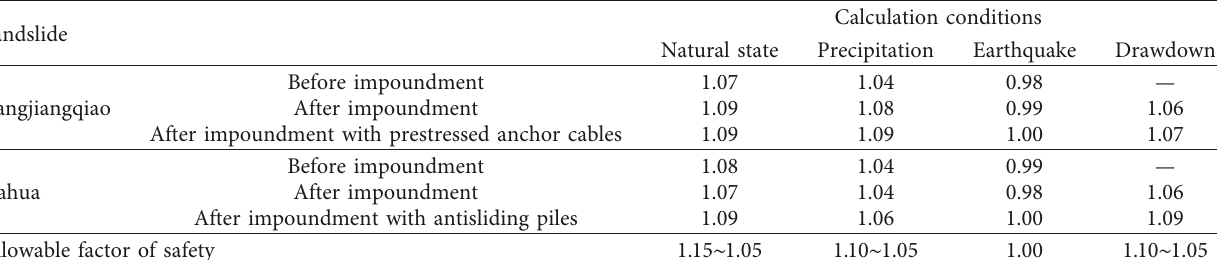
Table 9: Calculated factors of safety for Canjianqiao and Dahua